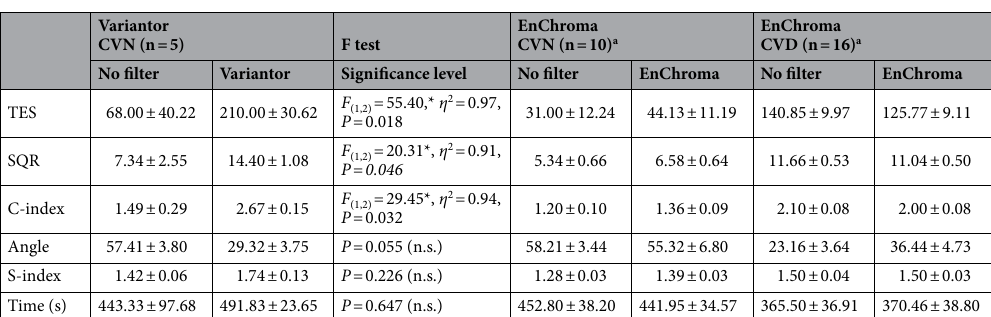
Figure 2. Mean Ishihara and FM100 TES (total error scores) scores, with and without filters. Average error scores (excluding misreadings) on the Ishihara test ( a ) and average TES scores on the FM100 test ( b ) for CVN-Variantor (red), CVN-EnChroma (grey), CVD-EnChroma (blue) adult conditions and CVD Children EnChroma (yellow) condition without filter (solid fill with skinny borders) and with filter (translucent fill with thick borders). Horizontal dashed lines represent cut-off points to “fail” the Ishihara ( a , 3 errors) and the FM100 ( b , 100 TES). Error bars indicate ± 1 standard error of the mean (SEM). *(P < 0.05), **(P < 0.01), ***(P < 0.001) and n.s. (not significant) indicate significance levels from the ANOVA tests or Tukey post-hoc comparisons.